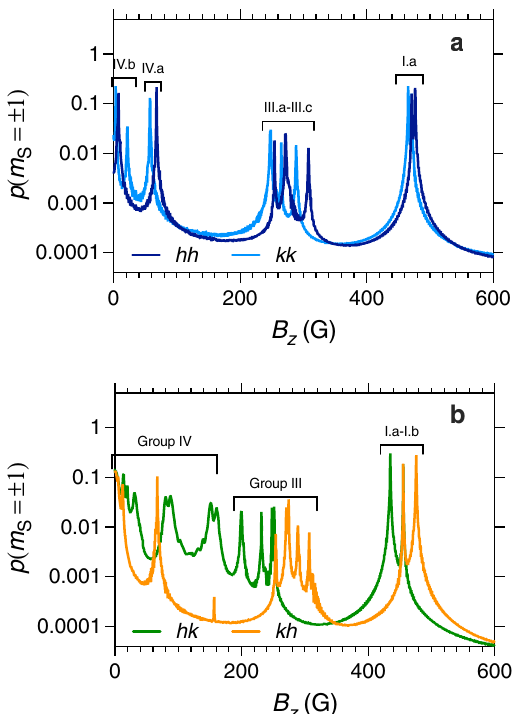
Fig. 6 Population of the m S = ±1 spin states of divacancies interact with other divacancy spins. a and b show the mixing curves on a logarithmic scale of the hh and kk and the hk and kh divacancy centers, respectively. In all cases, the spin bath contains all the possible divacancy con fi gurations other than the central divacancy under consideration. In a and b the magnetic fi eld is parallel to the quantization axis of the divacancy qubits in all cases. At t = 0, the central divacancy is initialized in the m S = 0 state, while the spin bath is in a high-temperature thermal state.